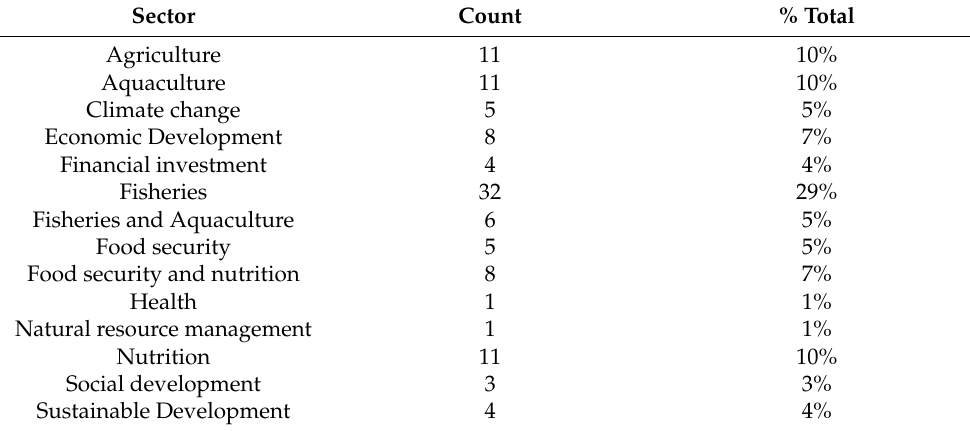
Table 4. Summary of sectors for documents